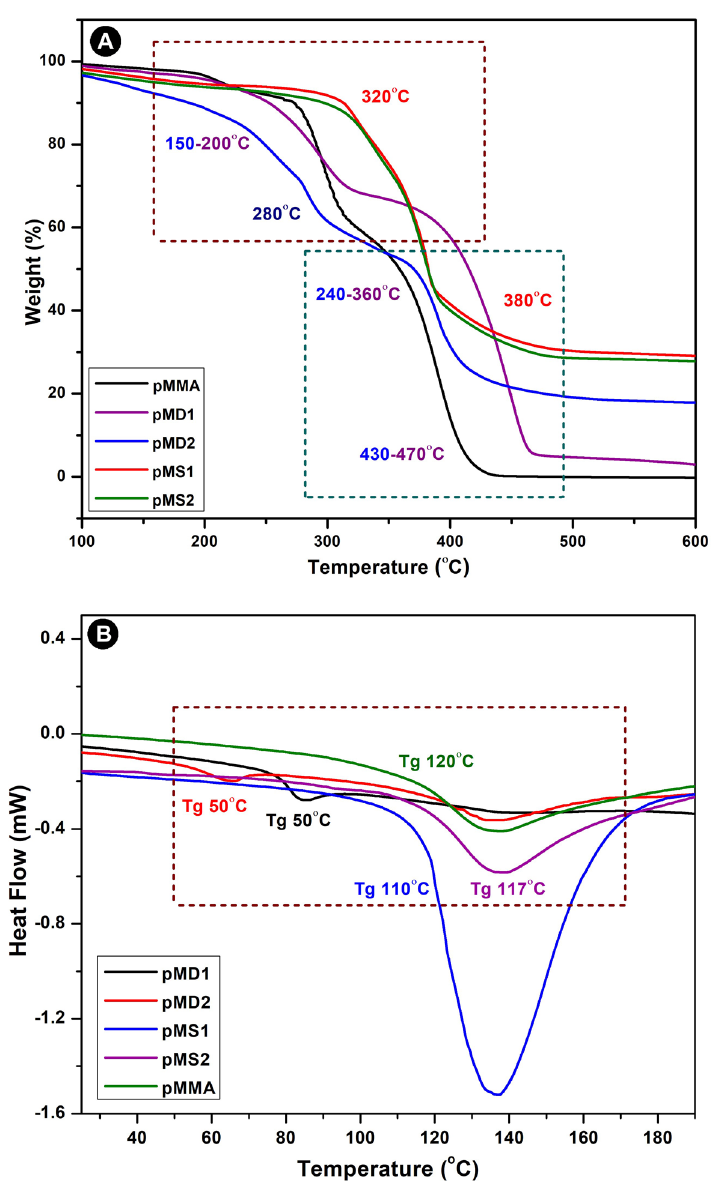
Figure 4. TGA(3A) & DSC (3B) analysis of polymers: p MMA, p MD1, p MD2, p MS1 and p